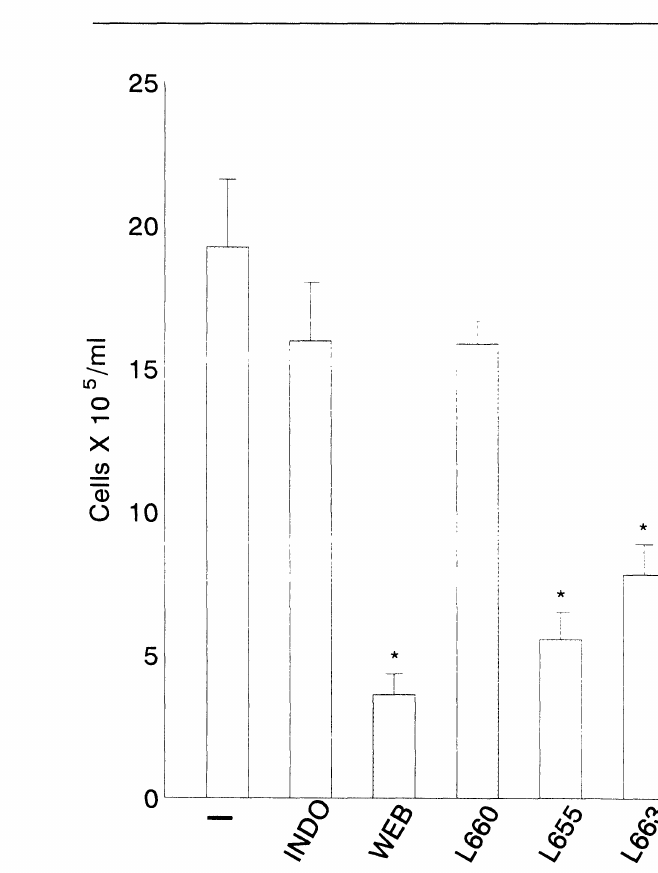
FIG. 3. Effect of treatment on the cellular influx into the synovial cavity of rats, 6 h after induction of IC arthritis. The first group received no treatment and the subsequent ones were pretreated with indomethacin (4mg/kg i.v.,